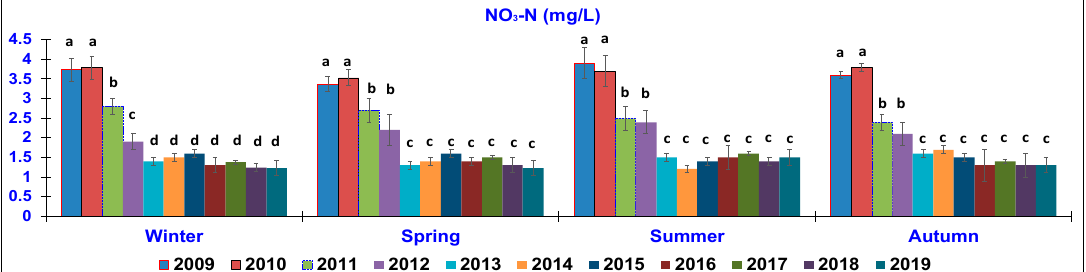
Figure 7. Trend of outlet water Nitrates (NO ₃ -N) (mg/L) (mean ± standard deviation) seasonally determined during the 10 year-study. Different letters (a, b, c, d) per season show significant differences ( p < 0.05) among the 10 years of sampling.